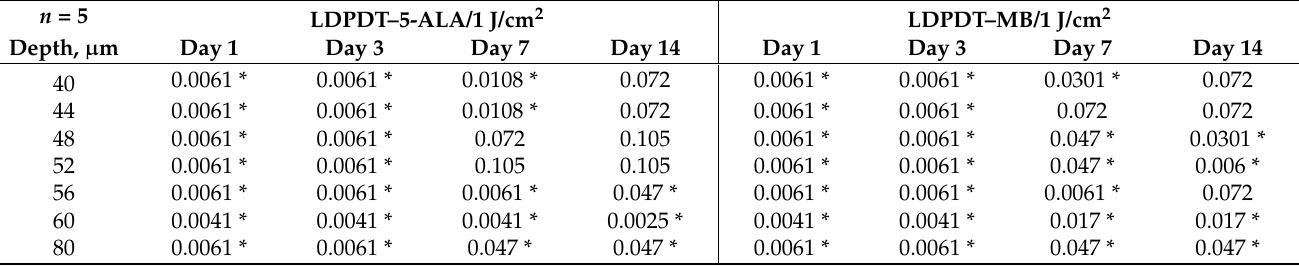
Table 4. The p -value for the SAAID in LDPDT 5ALA/1 J/cm 2 and MB/1 J/cm 2 relative to healthy